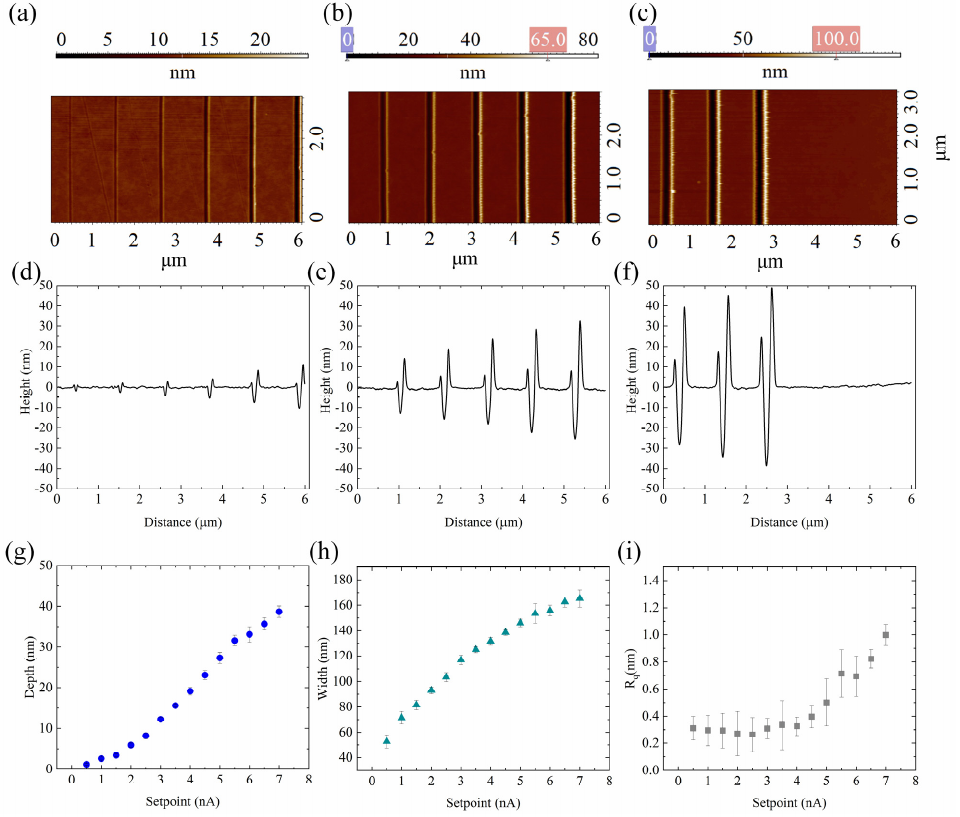
Figure 4. ( a – c ) SensHeight AFM images of nanochannels patterned on PMMA with an increasing setpoint value (from 0.5 to 7 nA in step of 0.5 nA) and ( d – f ) relative cross section profiles; ( g – i ) report the variation of the mean depth, width, and roughness for each fixed setpoint. The nanochannels’ depth is measured from the PMMA surface to the deeper part of the grooves while the width is defined by the full width at the top of the nanochannels. Both d and w were reported as mean values, obtained by averaging their values at twenty-five different locations, randomly chosen from the AFM topographical images. The pink and blue boxes on the z-scalebar in ( b , c ) indicate the minimum and maximum adjustment of the colour scale. The data reported in ( g , h ) are statistically significant for p < 0.001 while the data in ( i ) are statistically significant for p < 0.05. The flatness of the nanogrooves was estimated by measuring the 2D R q value in the middle of the nanogrooves. Regardless of the depth of the channels, the roughness values were very low, ranging from (0.3 ± 0.09) nm to (0.99 ± 0.08) nm, comparable to that of pristine PMMA.